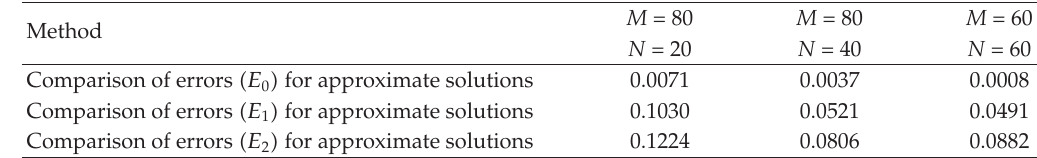
Table 2: Comparison of the errors for the di ff erence